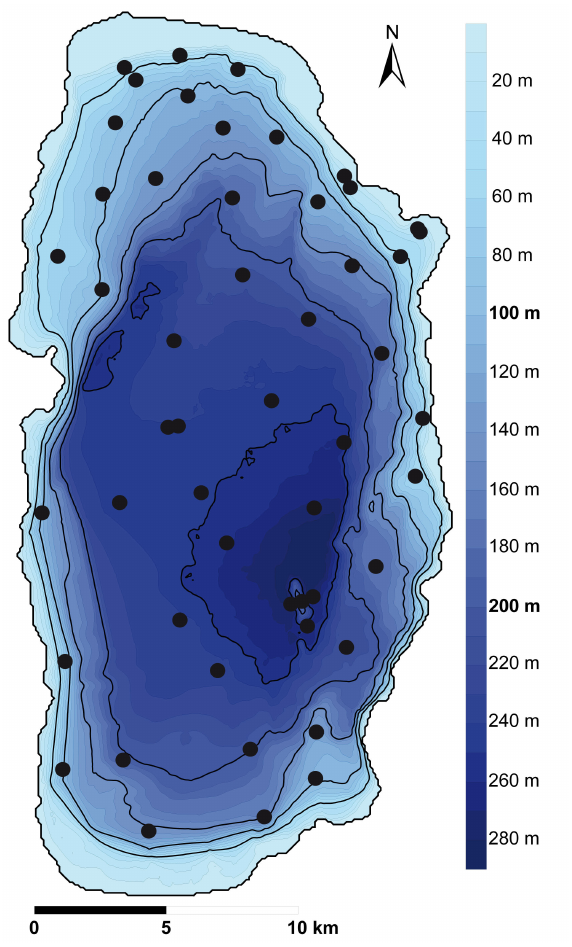
Fig. 2. Bathymetric map of Lake Ohrid with 10m contour inter- vals. Black lines denote 50m intervals (modified after Albrecht and Wilke, 2008). Black dots indicate surface sediment sampling